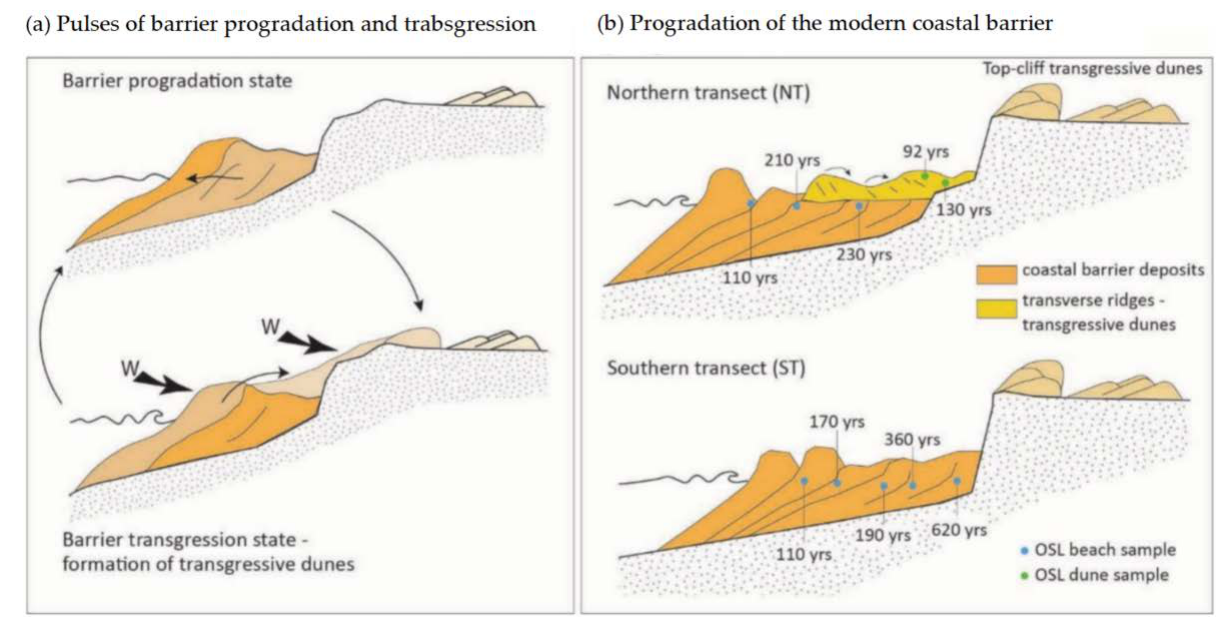
Figure 7. Panel ( a ) represents the states that the coastal barrier appears to display, alternating between a progradation state with seaward growth of the barrier, a transgressive state with a retreat of the coastline, the dismantling of the barrier and the transference of a part of the sand that eroded from the barrier to the transgressive dunes. Panel ( b ) represents the last pulse of barrier progradation documented by the collected stratigraphy and